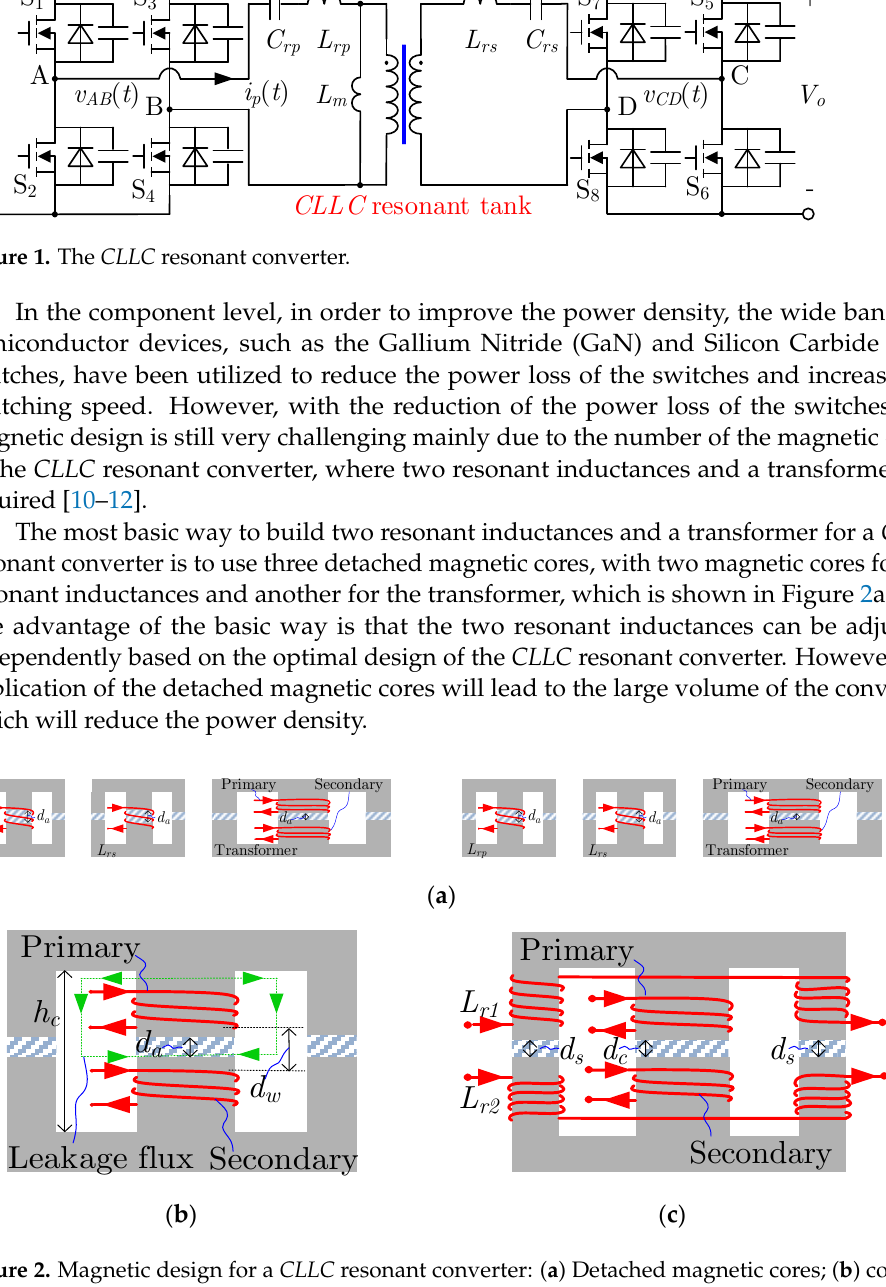
Figure 1. The CLLC resonant converter.